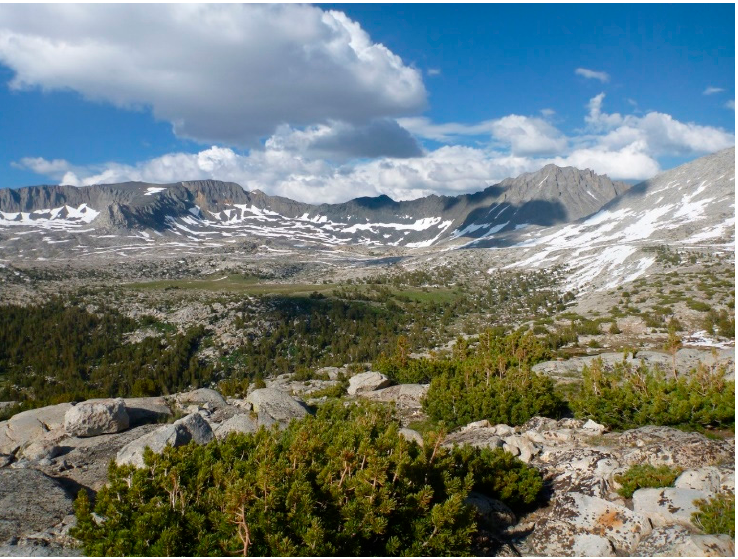
Figure 2. Whitebark pine near Kuna Crest, Yosemite National Park, CA, USA. Photo taken by Sierra Nevada Network forest monitoring crew, 2017.